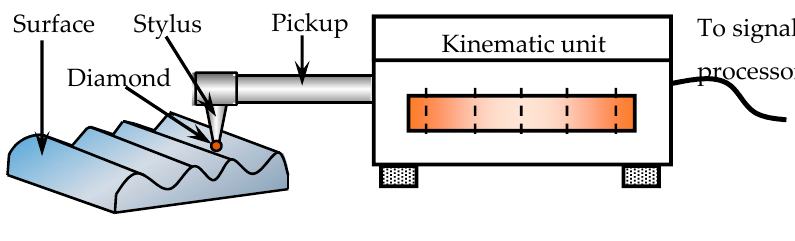
Figure 1. Profilometer sketch.